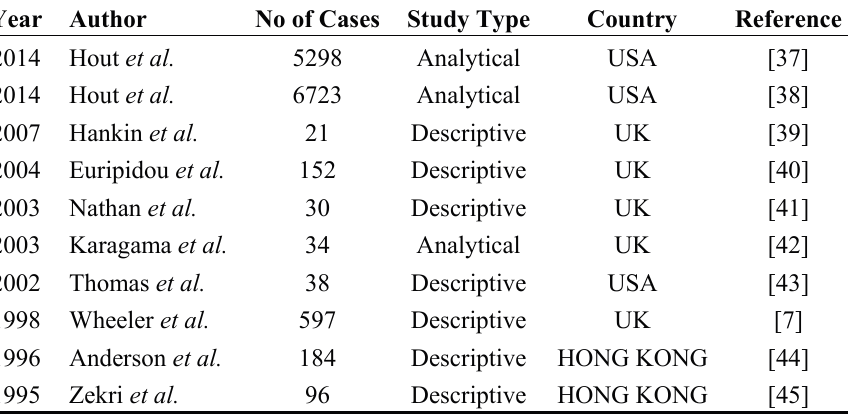
Table 2. Descriptive or analytical studies